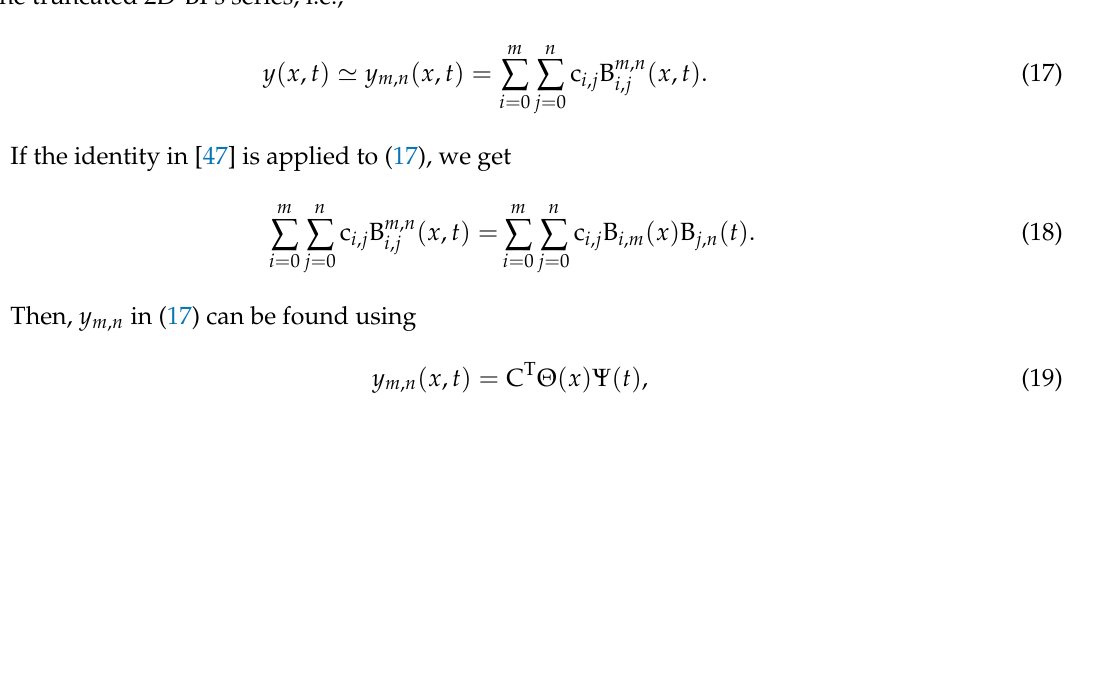
Figure 1. Two components of the two-dimensional Bernstein polynomials of order (5,5): ( a ) B 5,5 ( x , t ) and ( b ) B 5,5 1,3